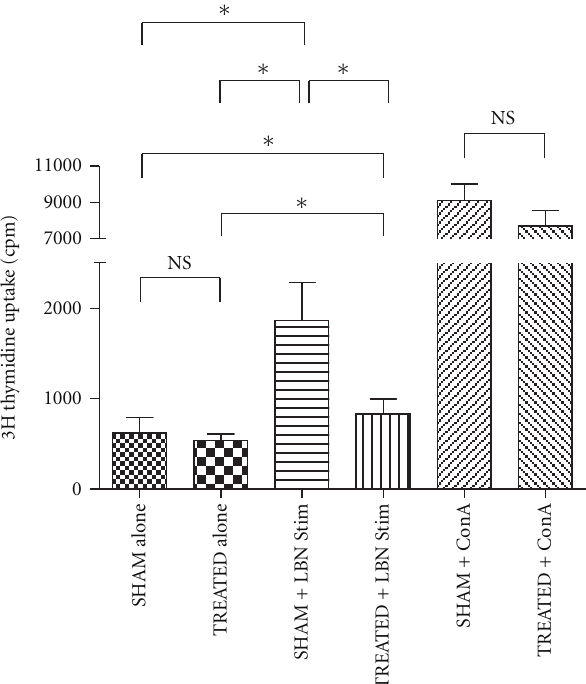
Figure 3: One-way MLR demonstrating significant donor-specific hyporesponsiveness conferred by seven consecutive daily intrajeju- nal doses of 5 × 10 7 LBN FDS. “ ∗ ” P < 0 . 05; “NS” P < 0 . 05.